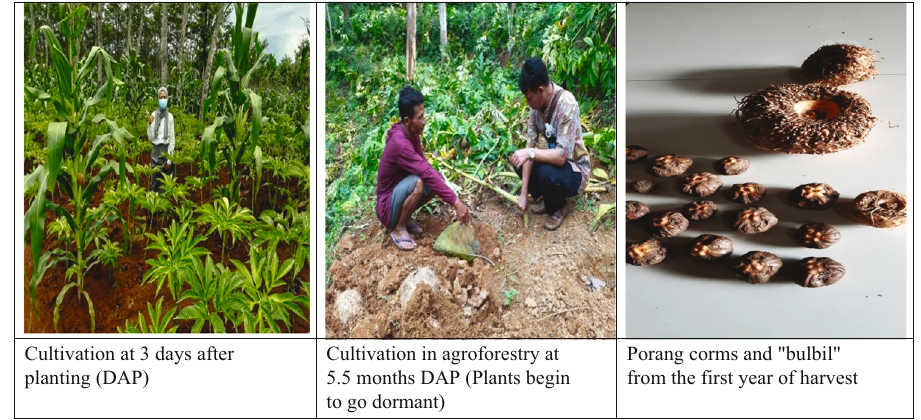
Figure 1: Porang cultivation in Wonogiri Regency. Cultivation at 3 days after planting ( DAP ) ; cultivation in agroforestry at 5.5 months DAP ( plants begin to go dormant ) ; porang corms and “ bulbil ” from the fi rst year of